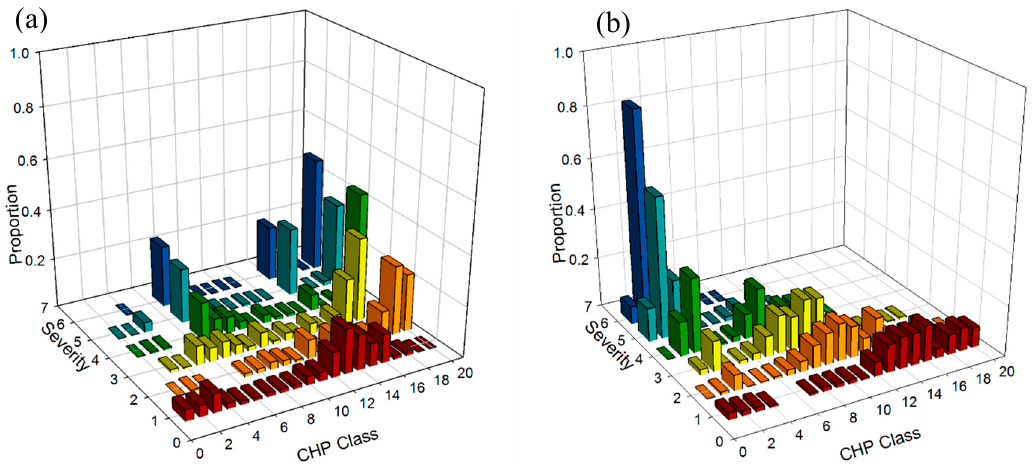
Figure 5. Proportion of CHP classes stratified by fire severity before and after fire. ( a ) Pre-fire landscape, ( b ) post-fire landscape.